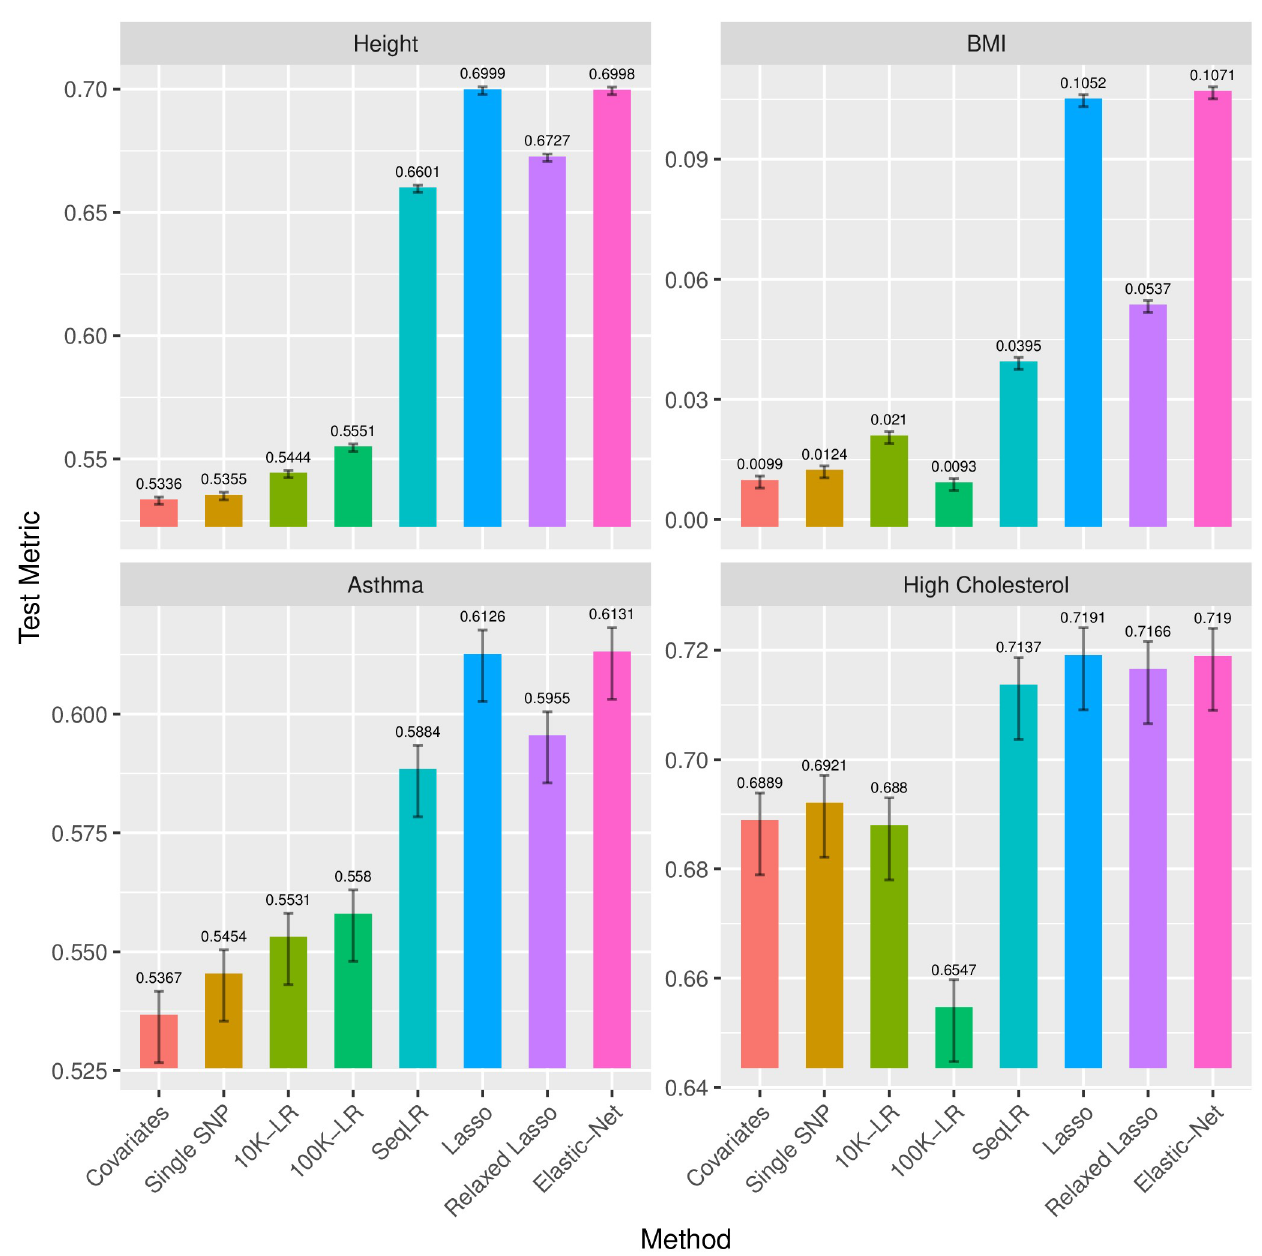
Fig 2. Comparison of the predictive performance of the different polygenic prediction methods evaluated on the test set. R 2 are evaluated for continuous phenotypes height and BMI, and AUC evaluated for binary phenotypes asthma and high cholesterol. The error bar uses 2 standard errors to show the statistical